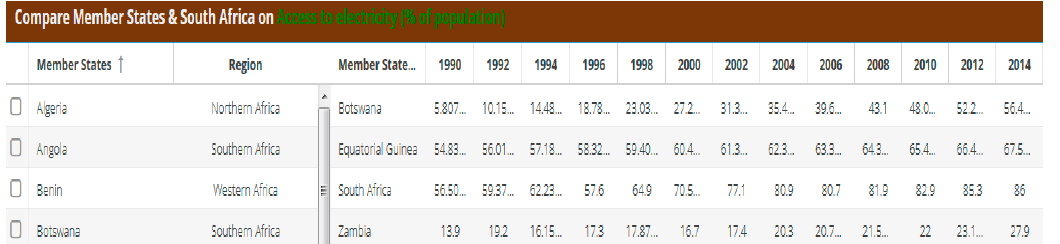
Figure 10. Example of a chart displaying the percentage of the population with access to electricity and how this varies over time.